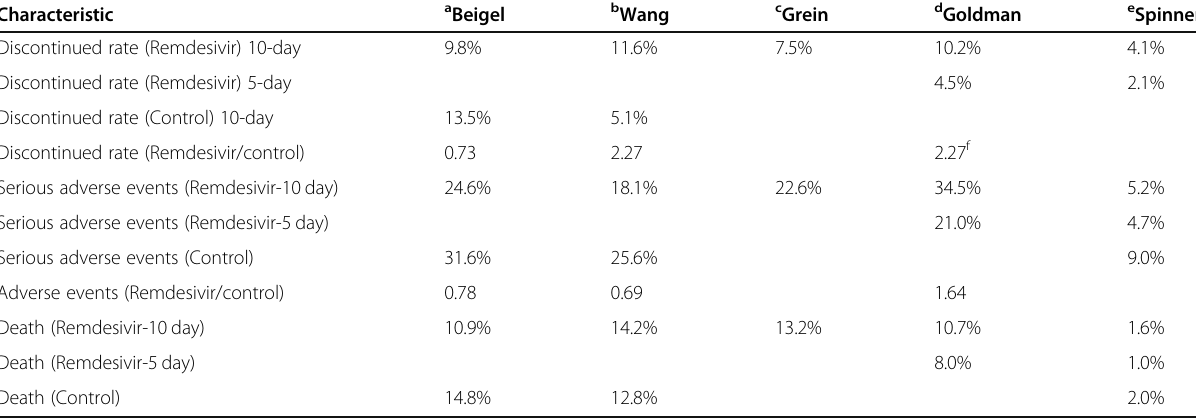
Table 3 Safety of remdesivir in human clinical trials Characteristic